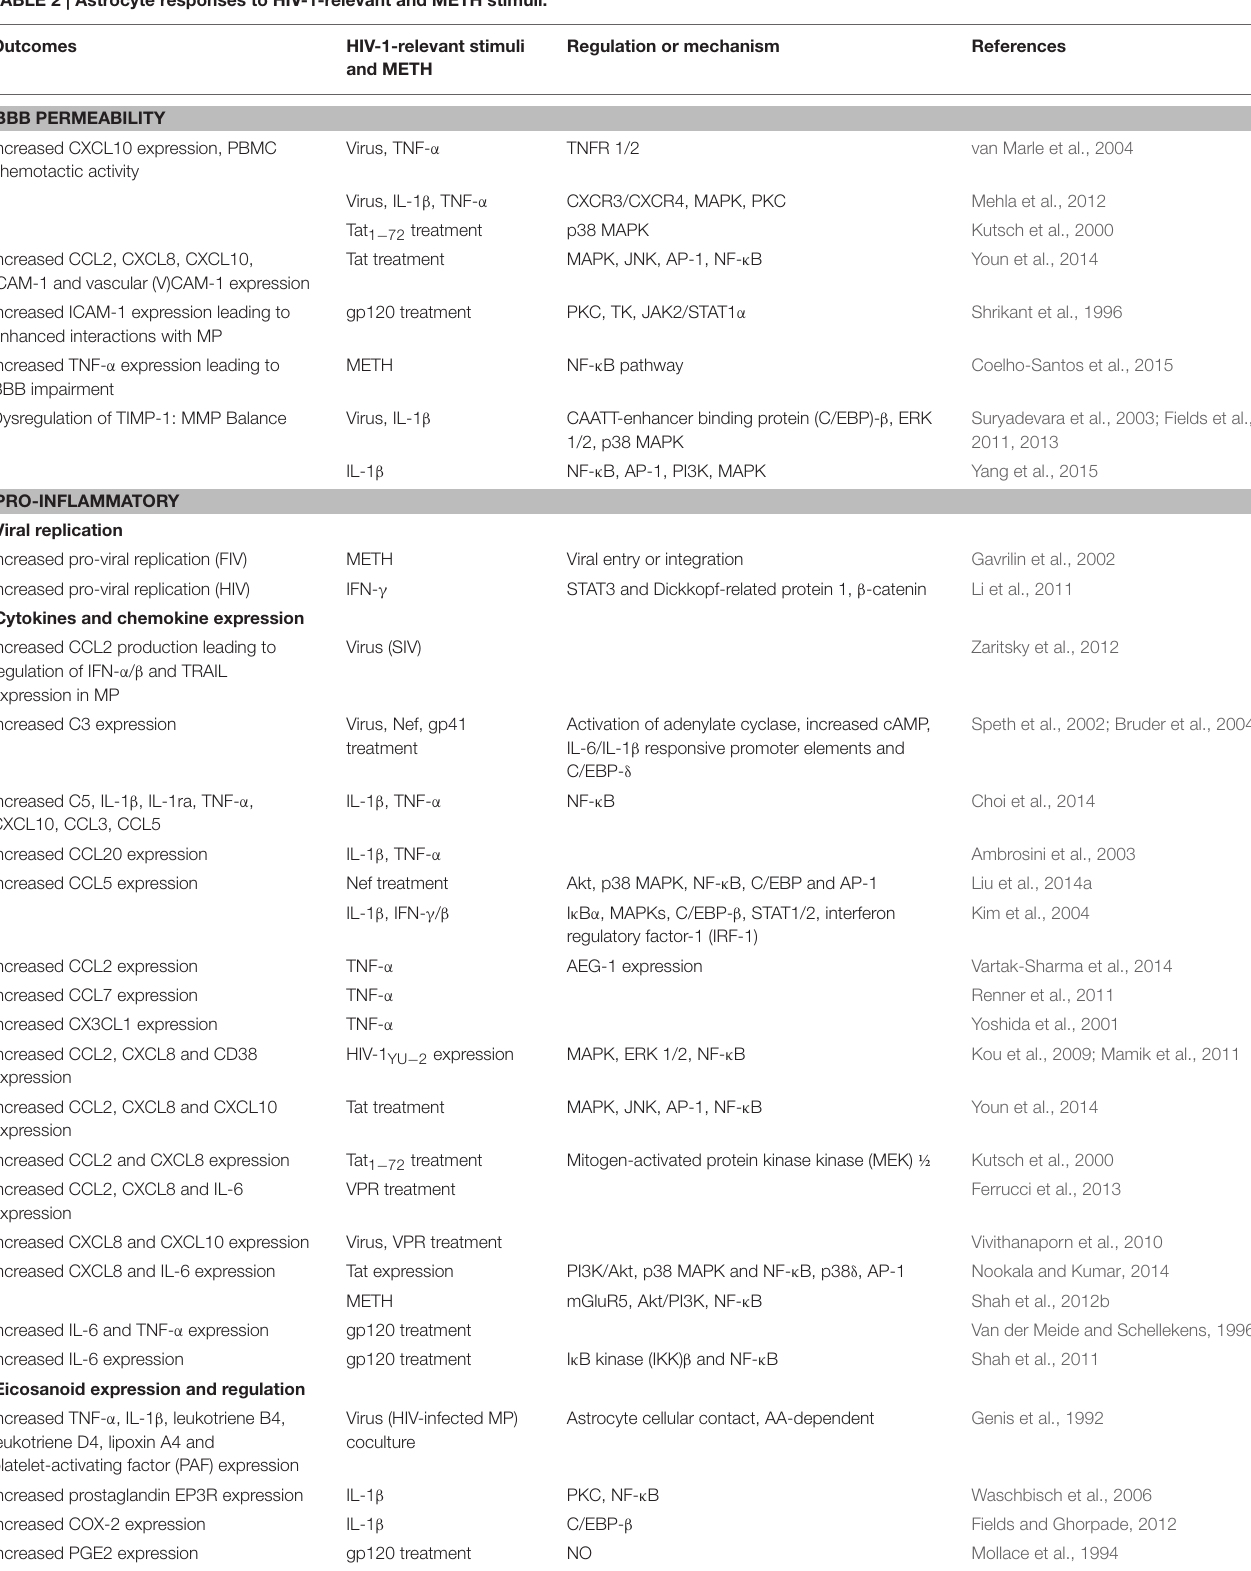
TABLE 2 | Astrocyte responses to HIV-1-relevant and METH